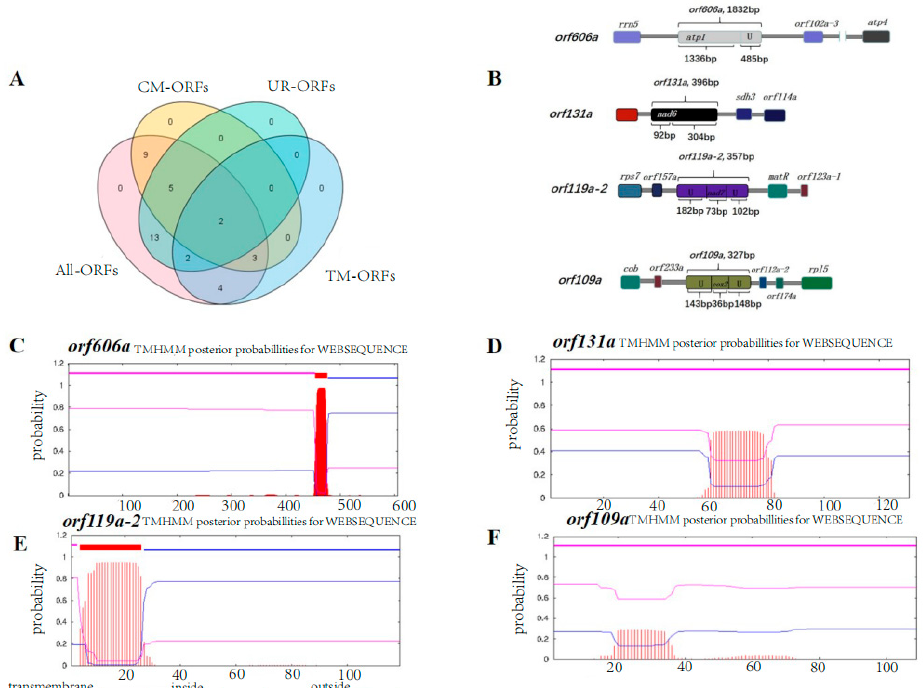
Figure 5. Distribution of four types of ORFs and chimeric structures, transmembrane domain of the specific ORF in SI3A. The Venn diagram ( A ) shows the distribution of four types of ORFs. All ORFs: numbers of all the detected ORFs in SI3A; CM-ORFs: numbers of chimeric structure ORFs in SI3A; UR-ORFs: numbers of unique region ORFs in SI3A; TM-ORFs: numbers of transmembrane domain ORFs in SI3A. ( B ) Chimeric structure of orf606a , orf131a , orf119a-2 , and orf109a . Rectangle boxes represent coding sequences, different colors represent different coding genes, linear represents the different size of the noncoding sequences, and U represents the unknown sequences. ( C – F ) The location and probabilities of transmembrane domains of the four specific ORFs orf606a ( C ), orf131a ( D ), orf119a-2 ( E ), and orf109a ( F